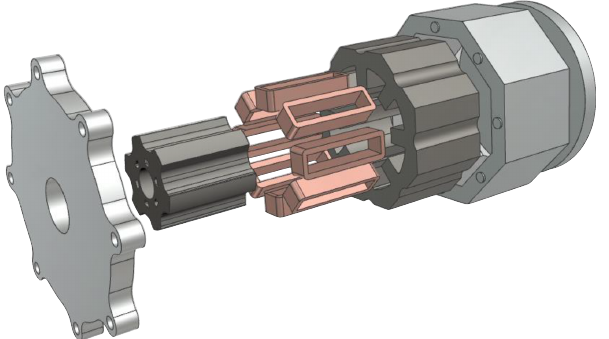
Figure 29. Exploded view of the final 8/6 SRM design with structural modifications for acoustic noise reduction (Design